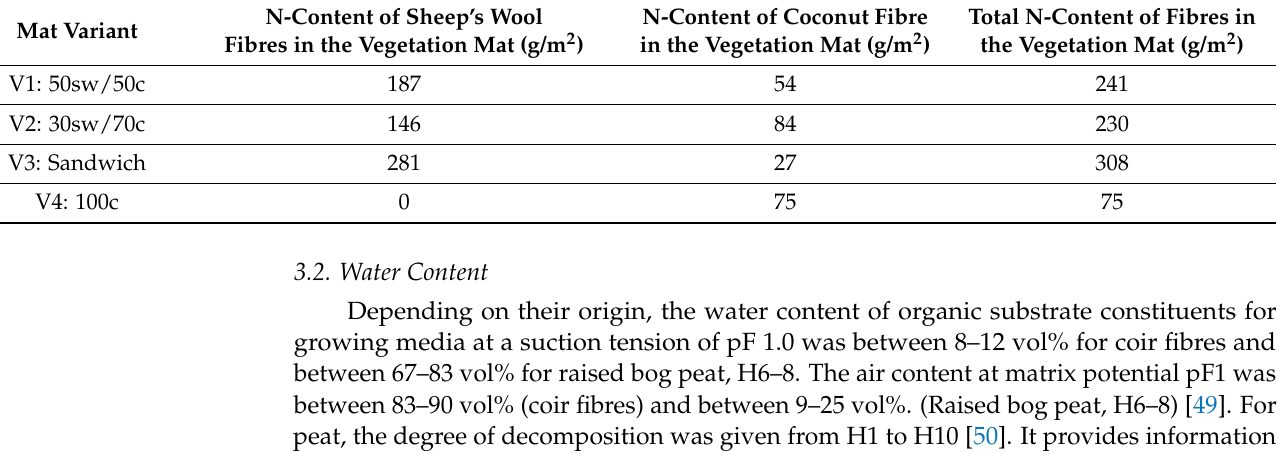
Table 3. Calculated nitrogen content of the fibres (air dry) of the used vegetation mats. Mat